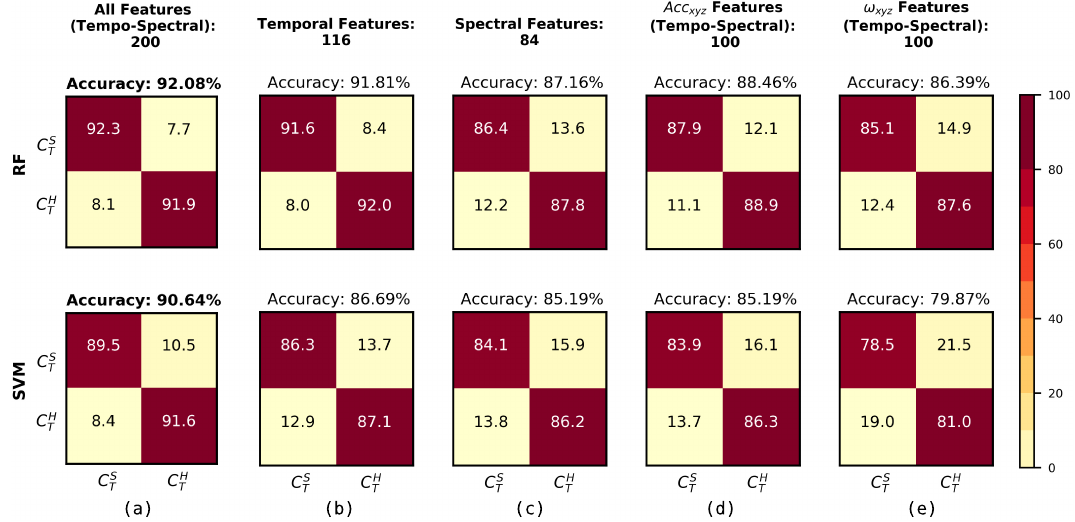
Figure 5. Confusion matrices of hard–soft terrain classification computed with lower back sensor. Each column represents a feature set: ( a ) all features (194 features), ( b ) time (110 features), ( c ) frequency (84 features), ( d ) accelerations (97 features) and ( e ) angular velocities (97 features). Each row represents a classifier (from ( top ) to ( bottom )): RF and SVM. Classes: C S = hard (concrete, Asphalt, and C H T